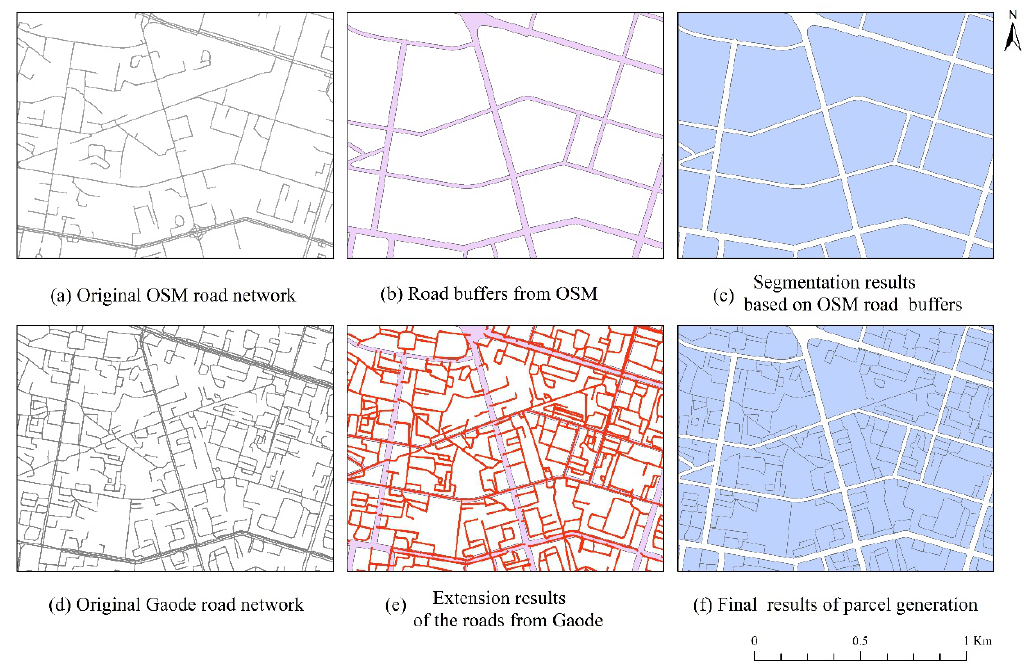
Figure 3. Parcel generation process combining OpenStreetMap (OSM) and Gaode roads.